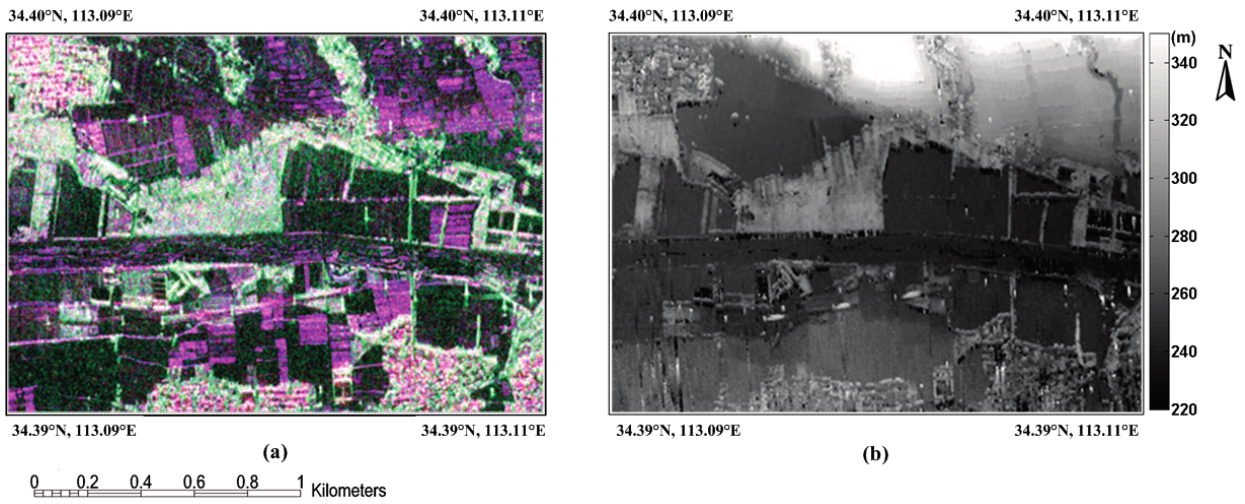
Figure 2. ( a ) P-band color-synthesized map of three Pauli basis polarizations (HH+VV, HV, HH-VV); ( b ) X-band elevation map generated by interferometric